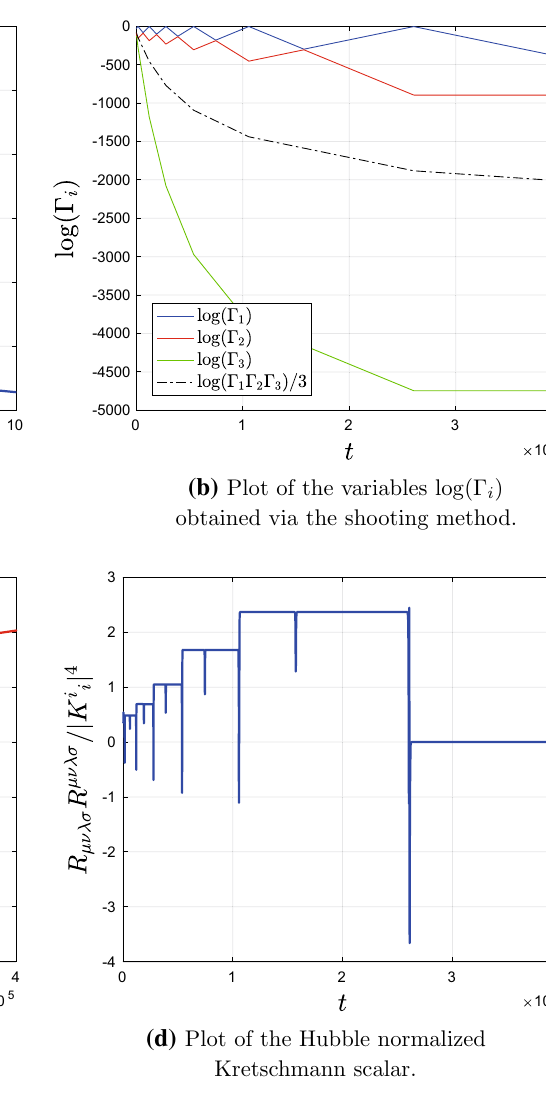
(c) Plot of the logarithm of the expansion.